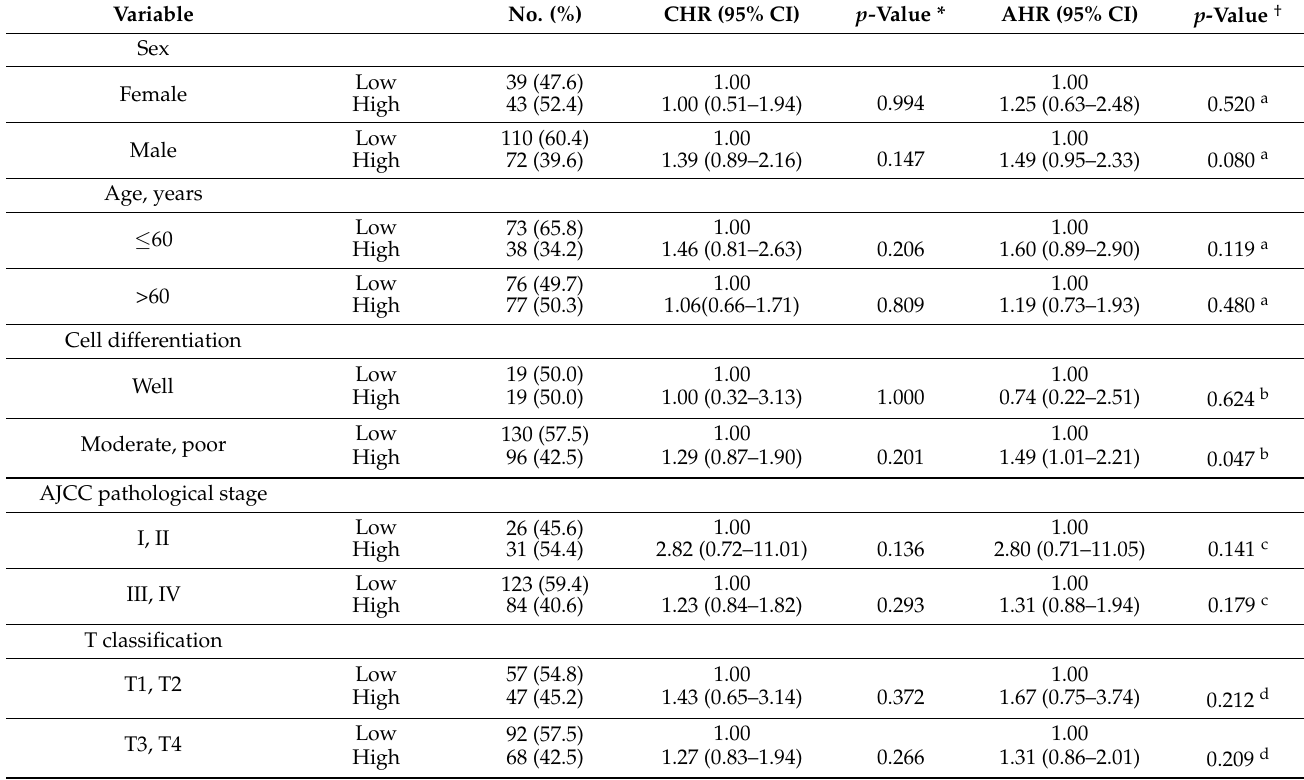
Table 2. The GBP5 gene expression in overall survival of oral cancer patients from TCGA